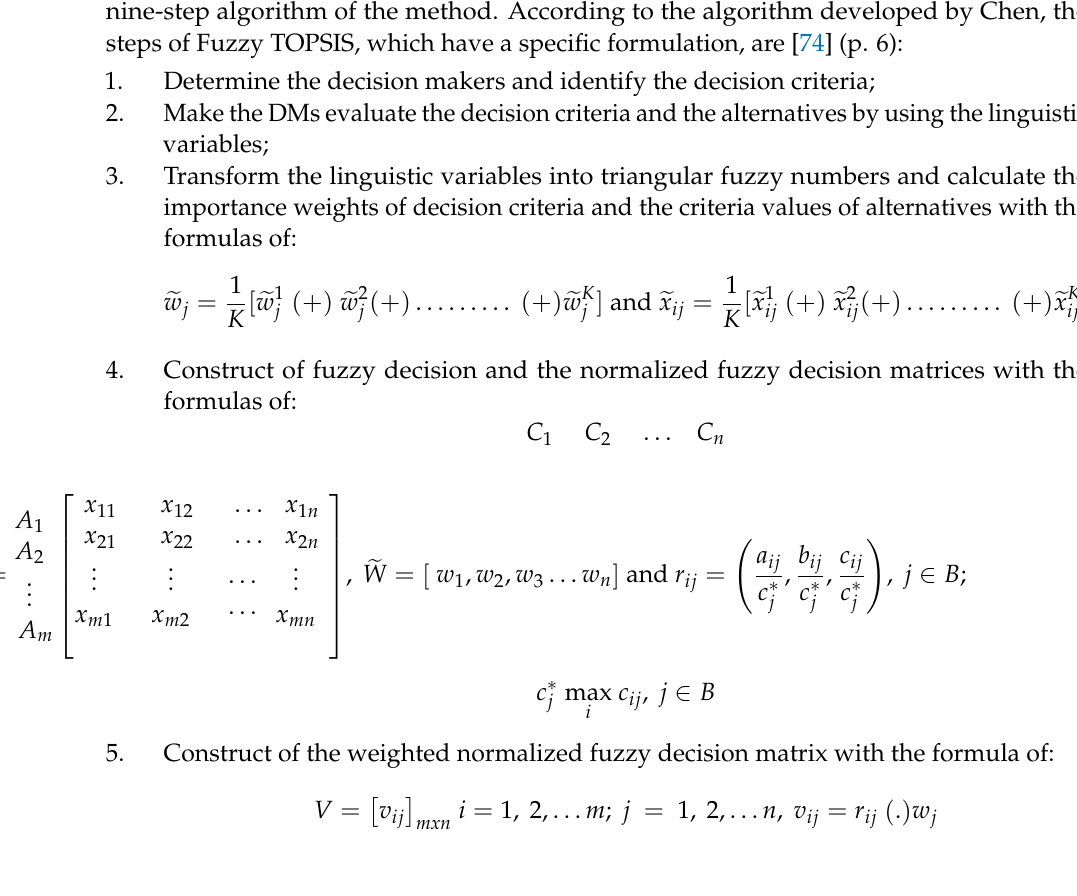
Table 2. Linguistic variables used for alternative criteria. VG Very Good